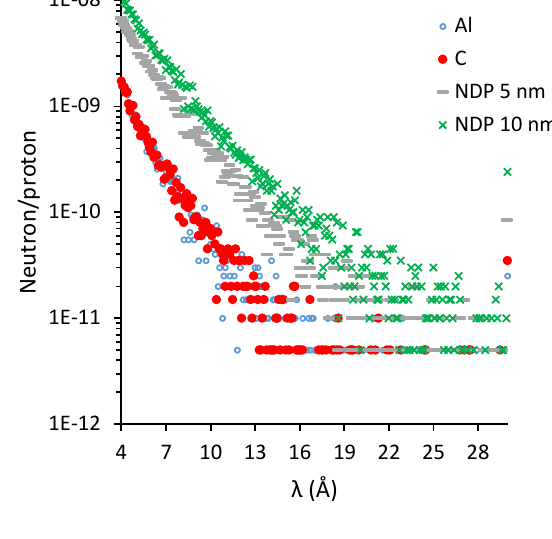
Fig. 11. CNS neutron spectrum with the wavelength more than 4 Å at exit.